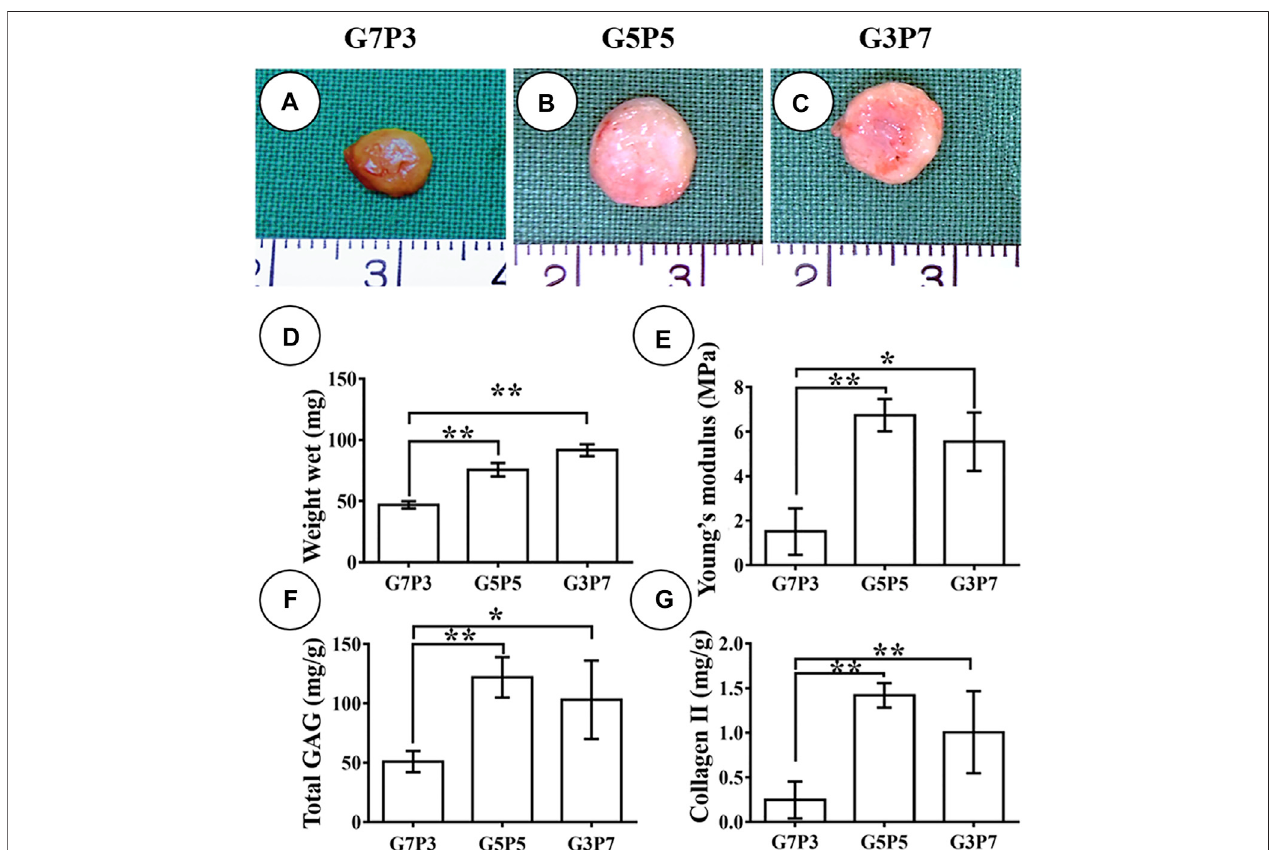
FIGURE3| Grossviewandquantitative analysisofengineeredtissuesat3 weeks invivo .ThesamplesinG7P3remarkablyshrinkandshowyellowish appearance (A) while the samples inG5P5 and G3P7groups retained theoriginalsize and show ivory-whiteappearance (B,C) . Quantitative analysisdemonstrates that the samples in the G7P3 group show lower values in wet weight, Young ’ s modulus, total GAG, and Collagen Ⅱ than those in G5P5 and G3P7 groups (D – G) . No obvious differences are observed in terms of wet weight, Young ’ s modulus, total GAG, and Collagen Ⅱ between the G5P5 group and the G3P7 group (D – G) . *Indicating signi fi cant differences (* p < 0.05; ** p <